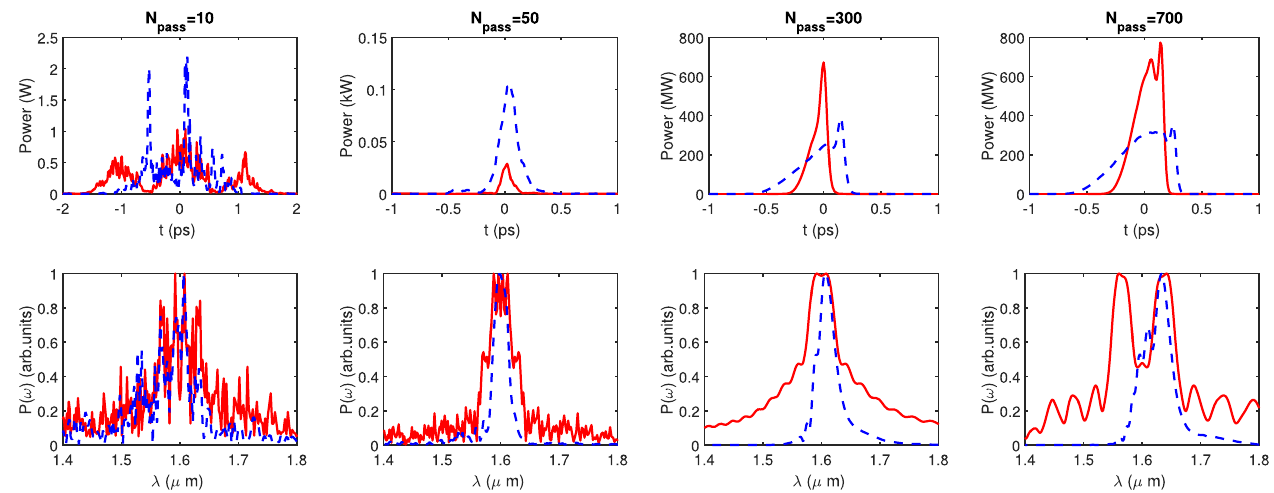
FIG. 5. The temporal and spectral profile of the output 1 . 6 μ m pulse in the normal FEL oscillator (blue dashed line) and the two-stage undulator cascaded FEL oscillator (red solid line), with the chicane delay of 1.0 ps. The output coupling efficiency is 6% and the cavity detuning length of 0 . 2 μ m for both of them. (The upper figures are manually shifted to the center.)